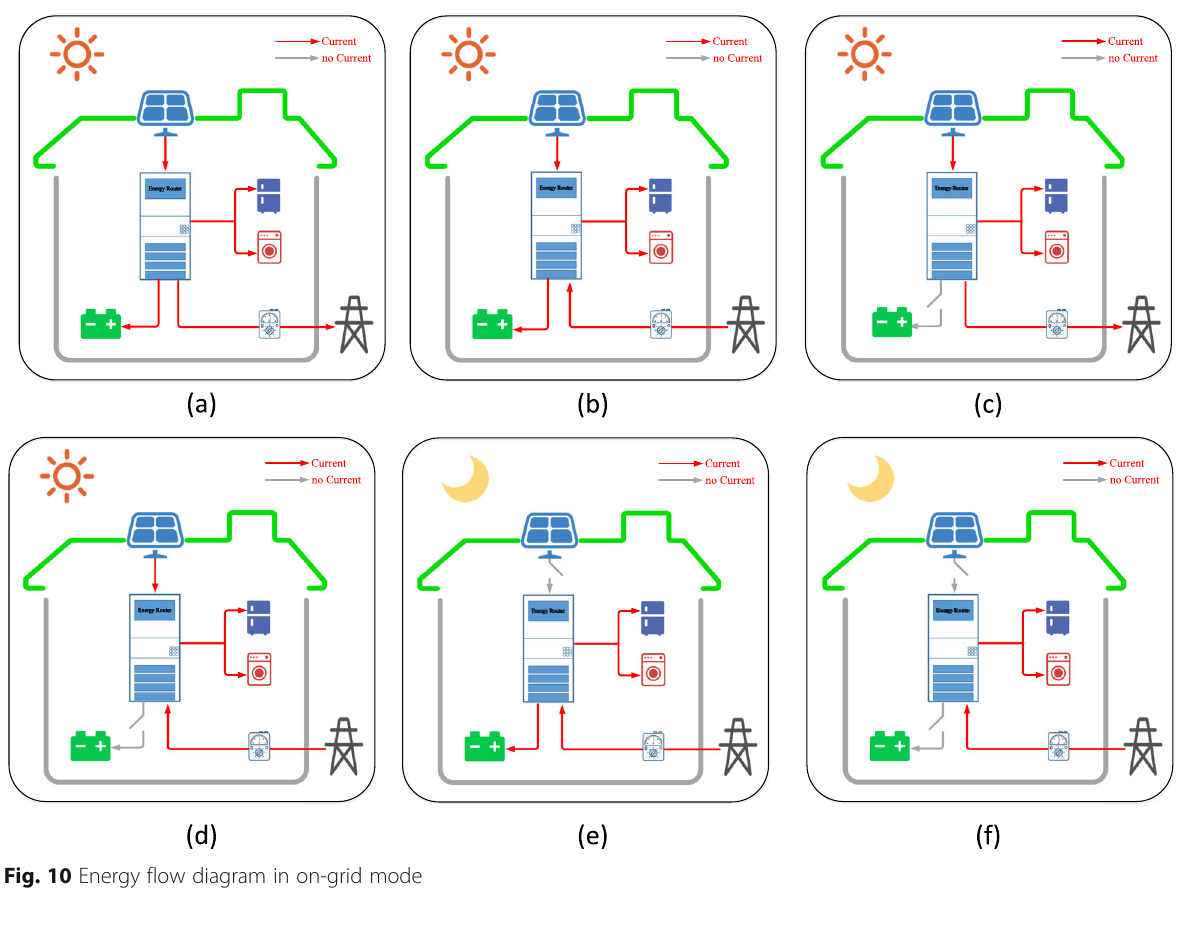
Fig. 10 Energy flow diagram in on-grid mode